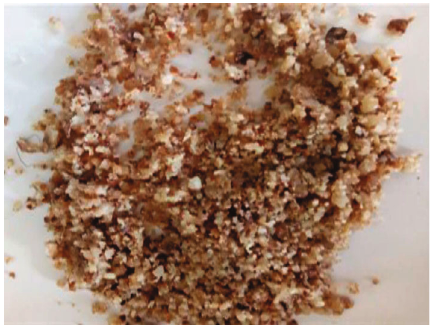
Figure 4: Pounded sample of Sclerocarya birrea seed